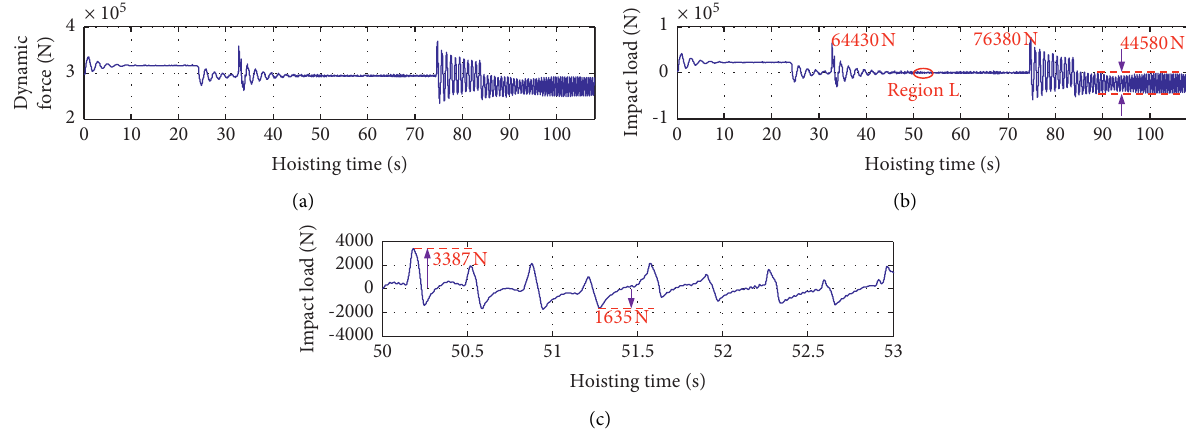
Figure 8: Dynamic load at the conveyance end of the rope. (a) Axial dynamic force at the conveyance end of the rope. (b) Impact load at the conveyance end of the rope. (c) Enlarged view of the region L.